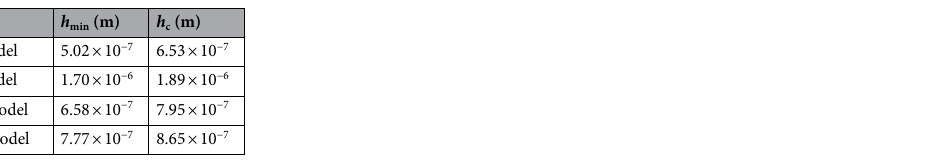
Table 5. Comparison of calculation results of different models with numerical simulation results.